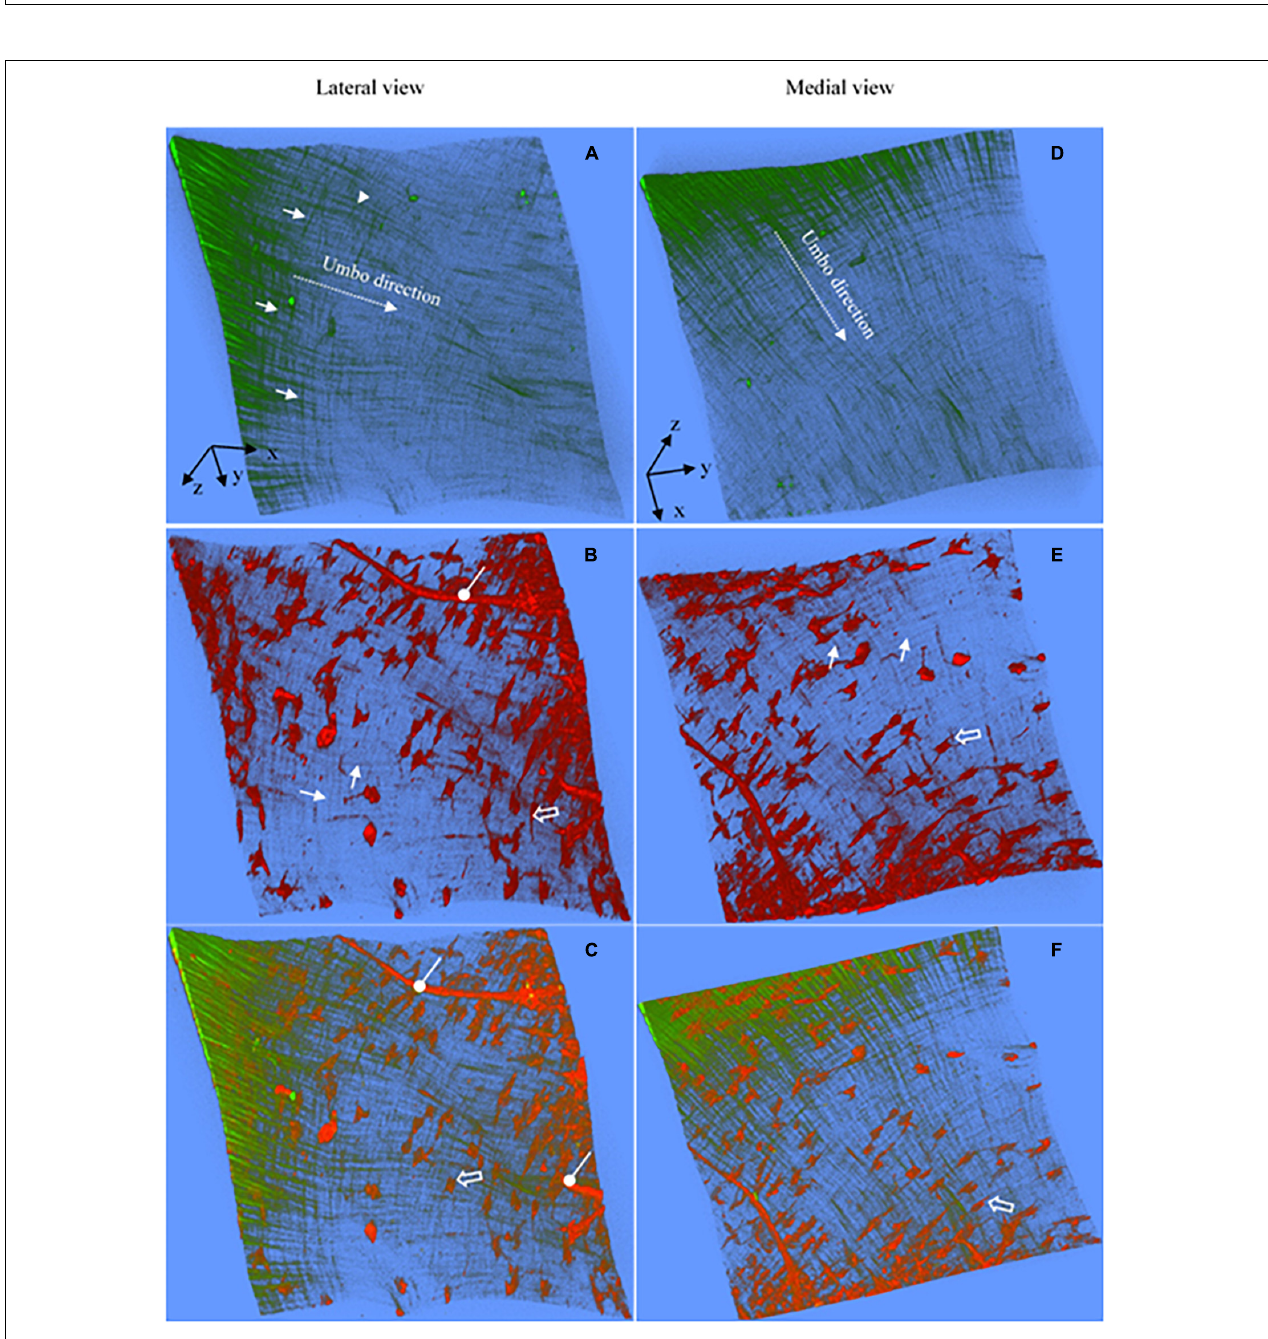
FIGURE 5 | Representative 3D images reconstructed from the SHG and TPF imaging stacks of the pars tensa near the TM center. (A,D) The 3D collagen framework of the pars tensa near the TM center. (B,E) The corresponding TPF images show the capillaries (oval arrows), vimentin positive cells in various shapes (hollow arrow) and elastic fibers (white arrows) running in the radial and circumferential direction. (C,F) The merged images highlight the colocalization of the collagen (green) with the elastic fibers, vimentin positive cells and capillaries. The collagen fibers become progressively thinner approaching to the TM center so that the collagen network (green) appears as “a wave collagen flag” scattered with the vimentin positive cells and capillaries. Field of the view: 509 × 509 µ m 2 .